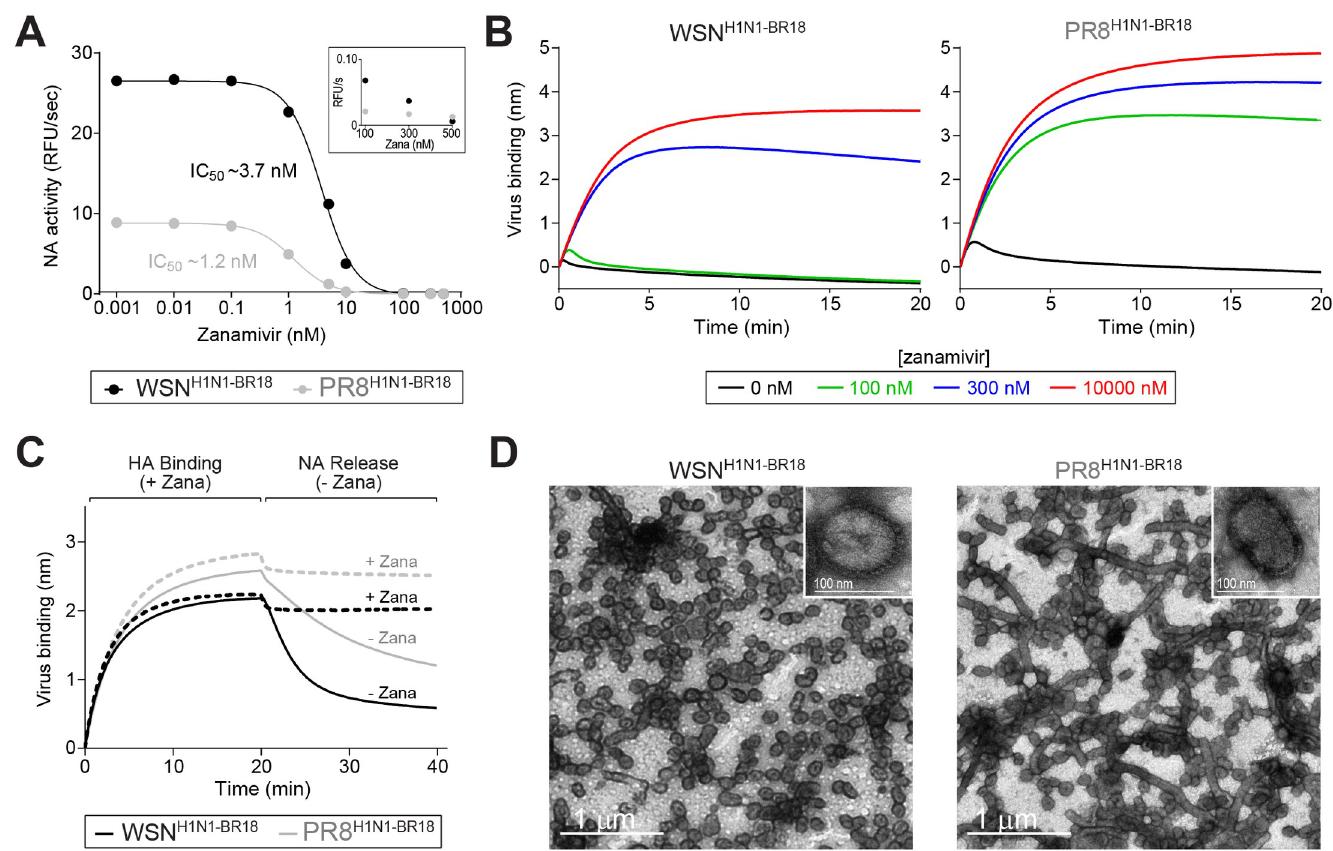
Fig 5. Property analyses of viruses with different NA to HA ratios. A. NA activity in the purified BPL inactivated viruses were measured using MUNANA in the presence of increasing zanamivir concentrations to calculate the 50% inhibitory concentration (IC 50 ). Measurements were made using 0.5 μ g of total viral protein. Inset shows the NA activity values at high zanamivir concentrations. B. Binding of purified WSN H1N1-BR18 virions (left graph) and PR8 H1N1-BR18 virions (right graph) to 3’-SLN were measured in the presence of the indicated zanamivir concentrations by biolayer interferometry (BLI). Each binding curve was generated with a biosensor containing the same density of immobilized 3’SLN and ~0.1 mg/ml of purified virus. C. HA binding of the purified virions (~0.1 mg/ml) to 3’SLN and NA- mediated release of bound virus were measured by BLI. HA-binding was monitored for 20 min in the presence of 10 μ M zanamivir to inhibit NA activity. The biosensor containing the bound virus was moved to a new well with (dashed line) or without zanamivir (line) and the NA-mediated release was followed. D. Negative stained transmission electron microscopy images of BPL inactivated purified WSN H1N1-BR18 and PR8 H1N1-BR18 virions. Insets contain higher magnification images of a spherical virion. Scale bars (white) are